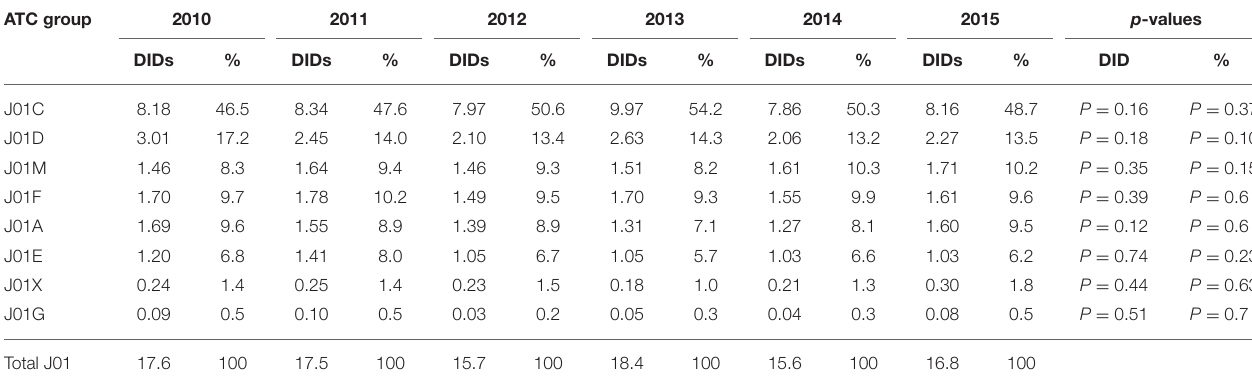
TABLE 1 | Total utilization of antibiotics for systemic use (J01 group) expressed in DIDs and percentages from 2010 to 2015. ATC group 2010